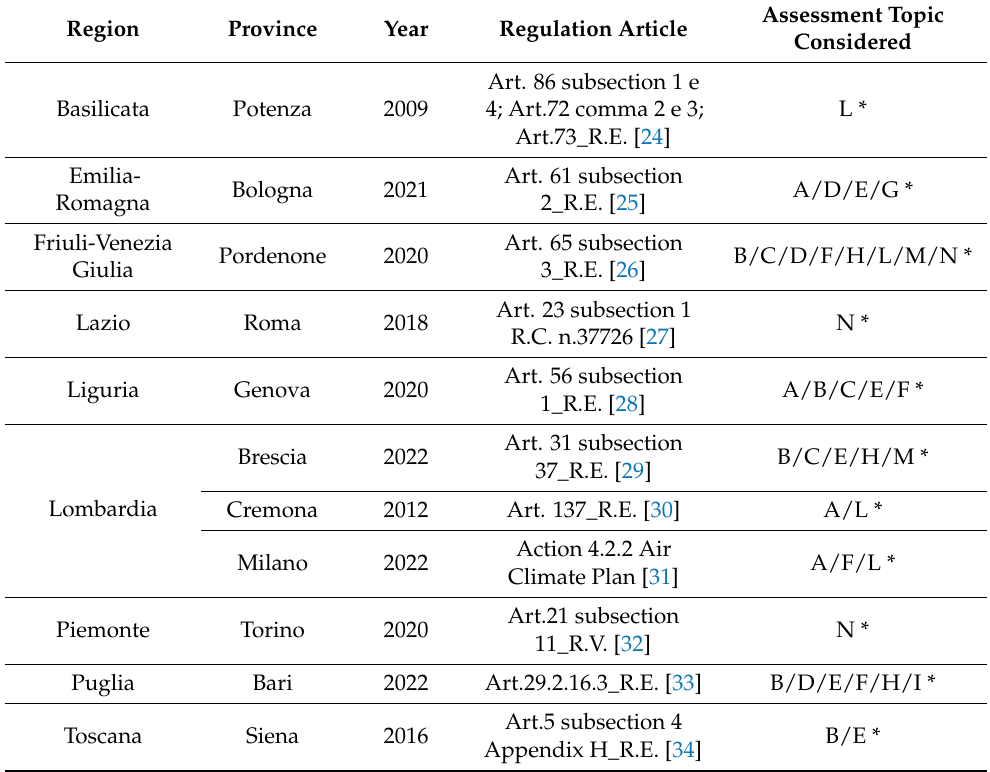
Table 2. Italian cities that introduce into municipal regulations, the use of green walls. In the table: R.E. stands for municipal building codes, Art. stands for article, R.C. means the municipal regulation for the urban environment for public and private greenery for Rome, and R.V. stands for the municipal regulation for public and private greenery for